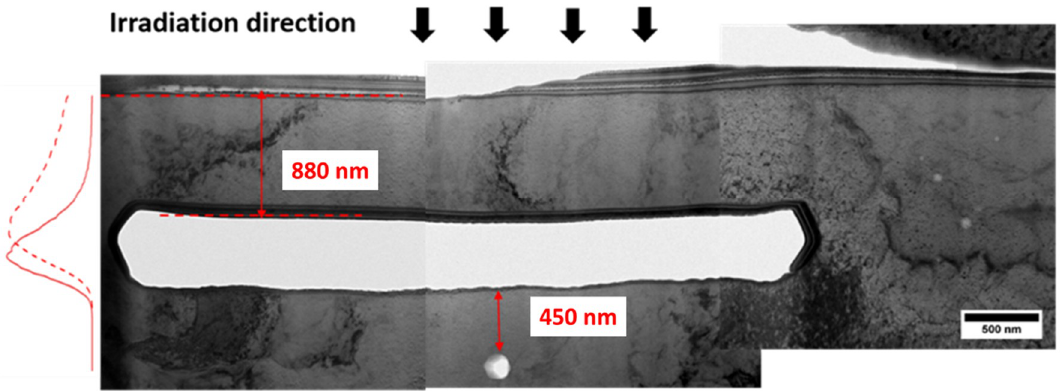
Figure 9. TEM micrograph of irradiated Fe containing a trench with an upper surface located at the depth corresponding to 0.88 µ m, missing the effect of the injected interstitial distribution.